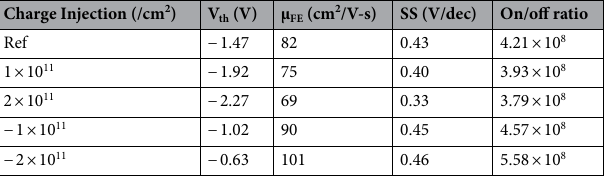
Charge Injection (/cm 2 )